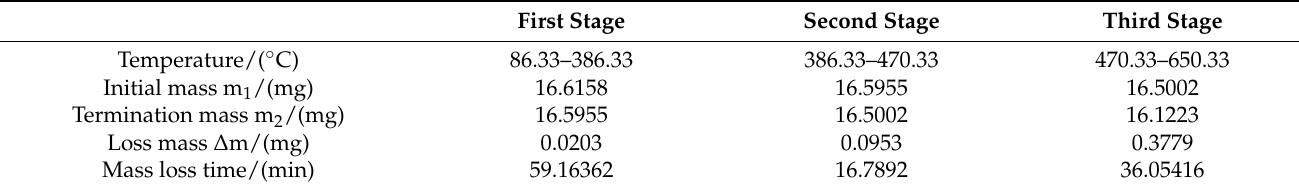
Table 9. Parameters of three stages of thermal decomposition of TiH 2 .